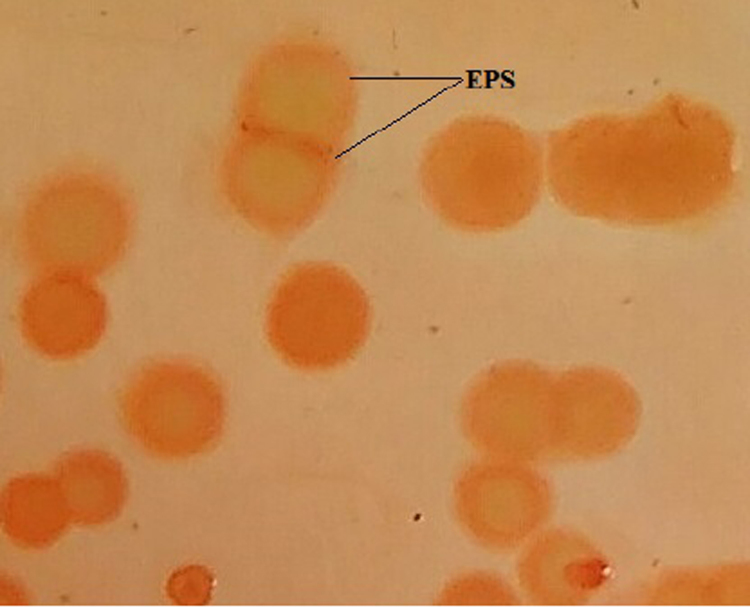
Congo red assay.